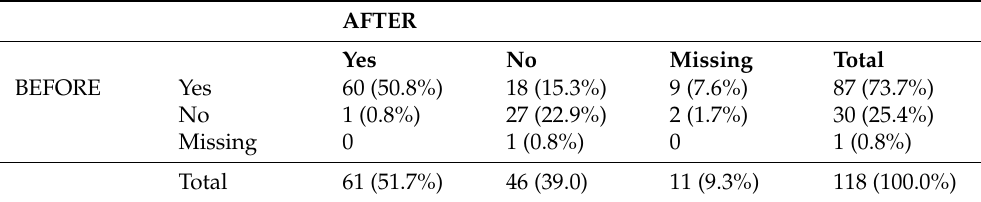
Table 4. Comparison of problematic use before and after the regulatory change for SCDD problematic users ( n =